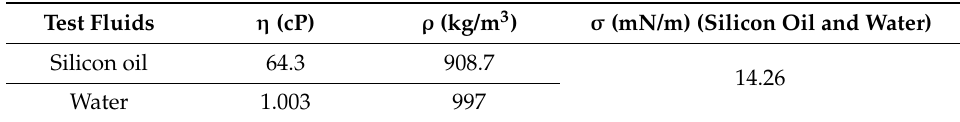
Physical property of the test fluids in droplet formation using our centrifugal microfluidic